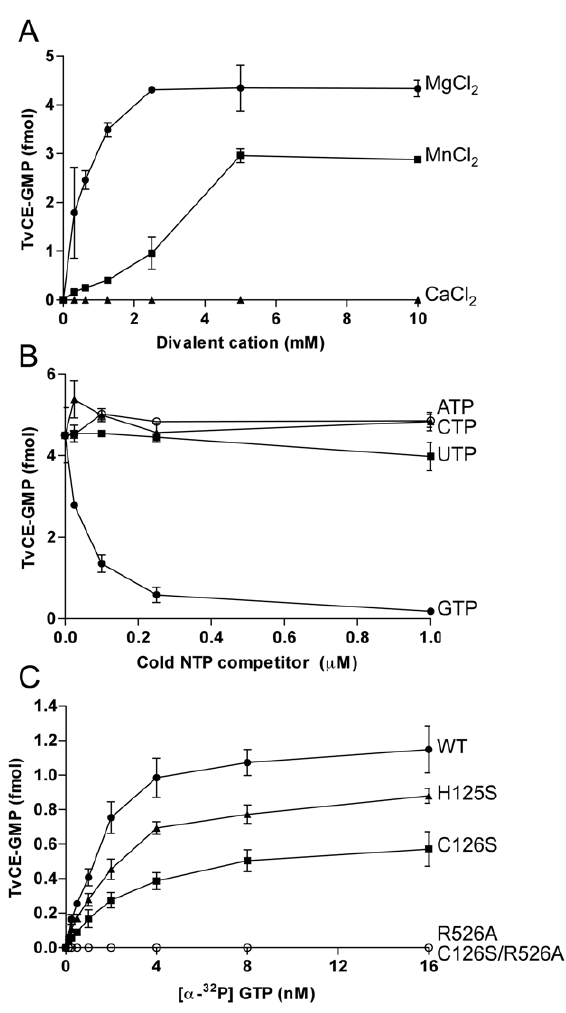
Figure 4. Guanylyltransferase activity recombinant TvCE. A. Effect of divalent cations Mg 2 + (filled circle), Mn 2 + (open square) and Ca 2 + (filled triangle). B. Effect of competition with cold nucleotides ATP (open square), CTP (filled triangle), UTP (filled square) and GTP (filled circle). C. Enzymatic activity of wild-type (WT) (filled circle) and mutants [R526A (open square), H125S (filled triangle), C126S (filled square), C126S/R526S (open square)] was compared across a range of [ a - 32 P]GTP concentration. Products were resolved on SDS-PAGE and quantified by liquid scintillation.